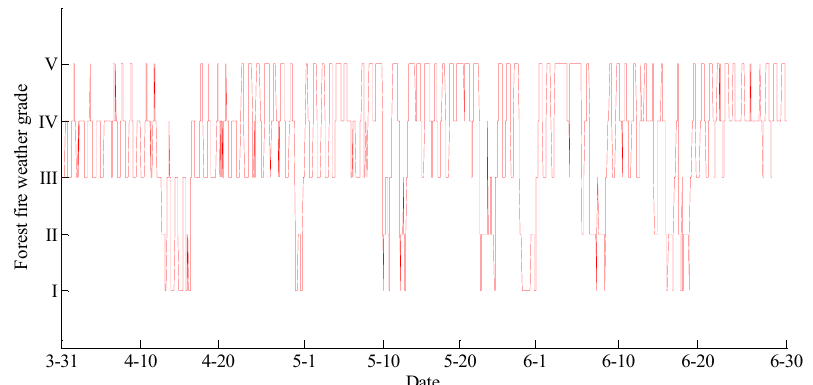
Figure 19. The curve of rainfall in Hulun Buir.